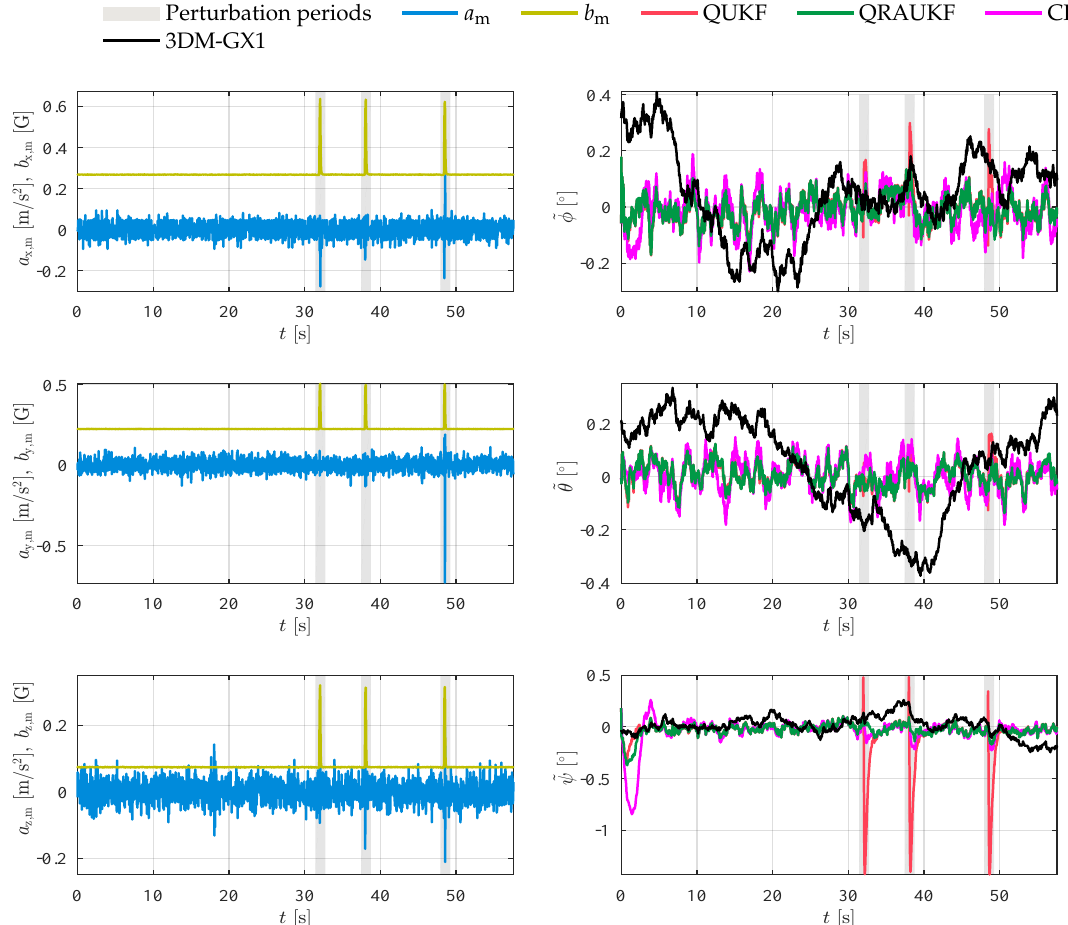
Figure 3. Results for abrupt magnetic disturbances experiment, scenario (i). In the left column, linear acceleration a m and magnetic field b m measurements, in the right column, the attitude